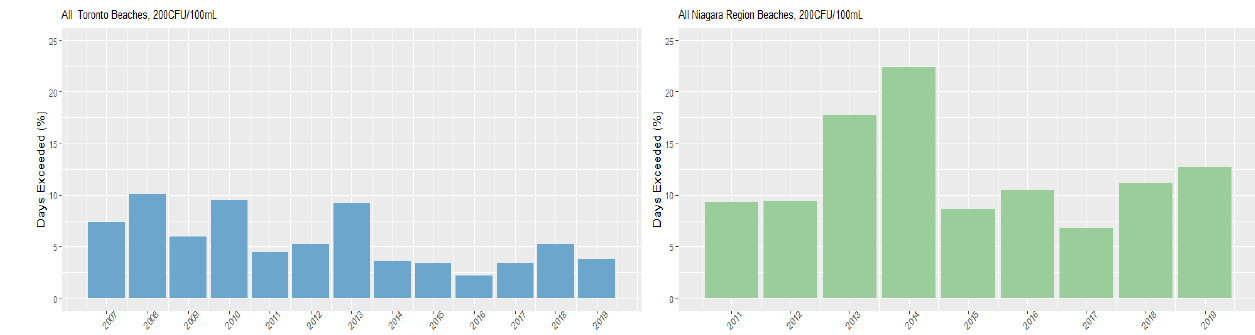
Figure 5. Annual E. coli threshold exceedances—200 CFU/100 mL.